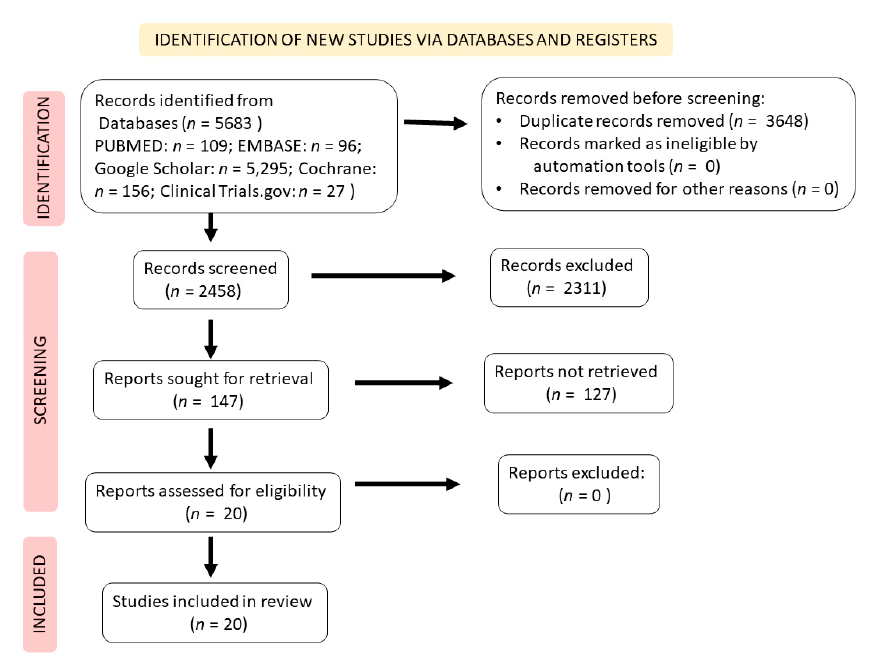
Figure 2. Flow diagram showing the literature search and study selection criteria. Analysis of the literature and writing of the manuscript were performed in accordance with the Preferred Reporting Items for Systematic Reviews and Meta-Analyses (PRISMA) guidelines [63].